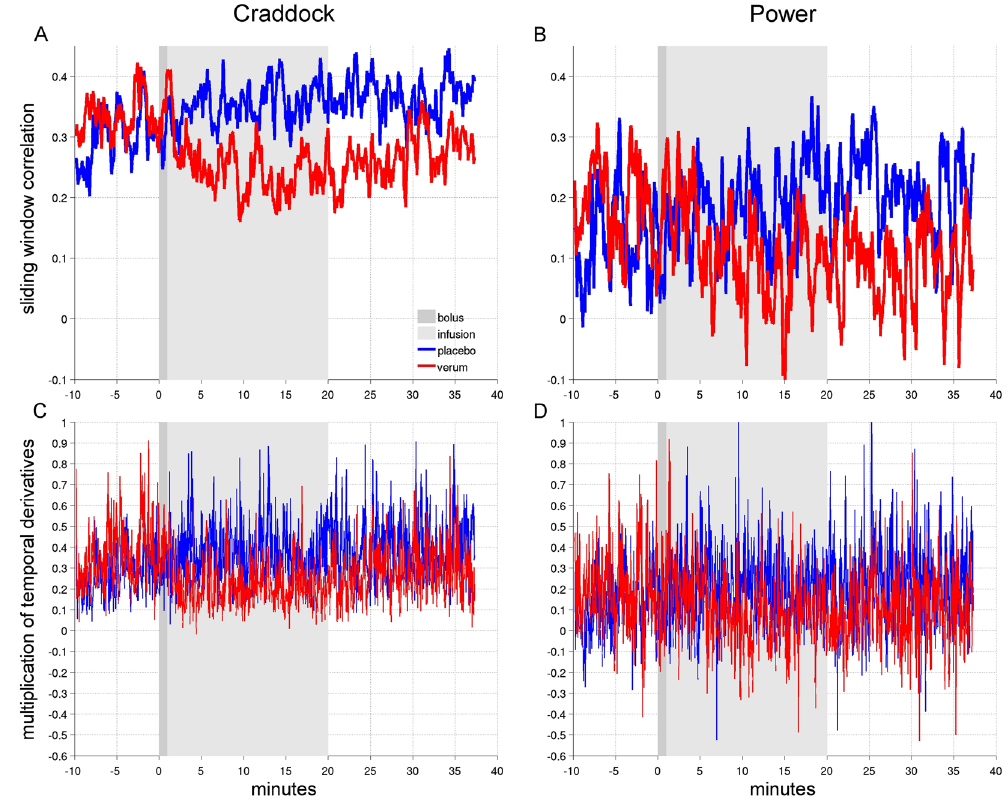
Figure 2. Time-course of average dynamic rsFC under esketamine and placebo. Esketamine reduced dynamic rsFC in comparison to placebo. Figure displays rsFC averaged from connections for which NBS revealed that correlation with esketamine plasma level time-course was shown to be significantly stronger for the test condition than for the placebo condition in all methodological approaches (Table 1). Red and blue lines denote average dynamic rsFC under esketamine and placebo, respectively. Exponentially weighted sliding-window correlation method based on Zalesky et al . 25 ( A,B ) and MTD based on Shine et al . 26 ( C,D ) were utilized for estimation of dynamic rsFC. Both procedures were performed using the atlases by Craddock et al . 29 and Power et al . 30 . Grey bars demark esketamine administration (Esketamine i.v. (0.11 mg/kg bolus over one minute (dark grey) followed by 0.12 mg/kg over 19 minutes (light grey))/Placebo i.v. (0.9%